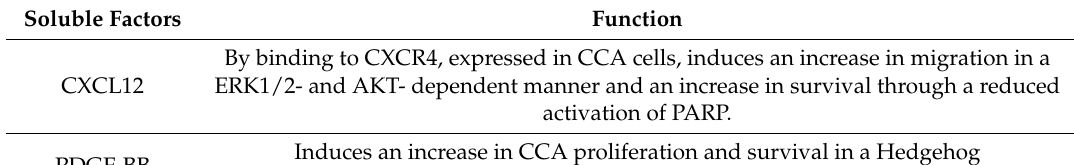
Effects of soluble factors secreted by Cancer Associated Fibroblasts (CAFs) on Cholangiocarcinoma (CCA) cells. Soluble Factors Function By binding to CXCR4, expressed in CCA cells, induces an increase in migration in a CXCL12 ERK1/2- and AKT- dependent manner and an increase in survival through a reduced activation of PARP. Induces an increase in CCA proliferation and survival in a Hedgehog PDGF-BB signaling-dependent manner. Promotes migration and invasion of CCA cells through phosphorylation of EGFR and HB-EGF activation of its signaling. Facilitates tumor progression by binding AT-1 receptor, expressed in CCA cells. AngII Induces survival of CCA cells and HSCs promoting tumor growth in an autocrine and paracrine fashion.